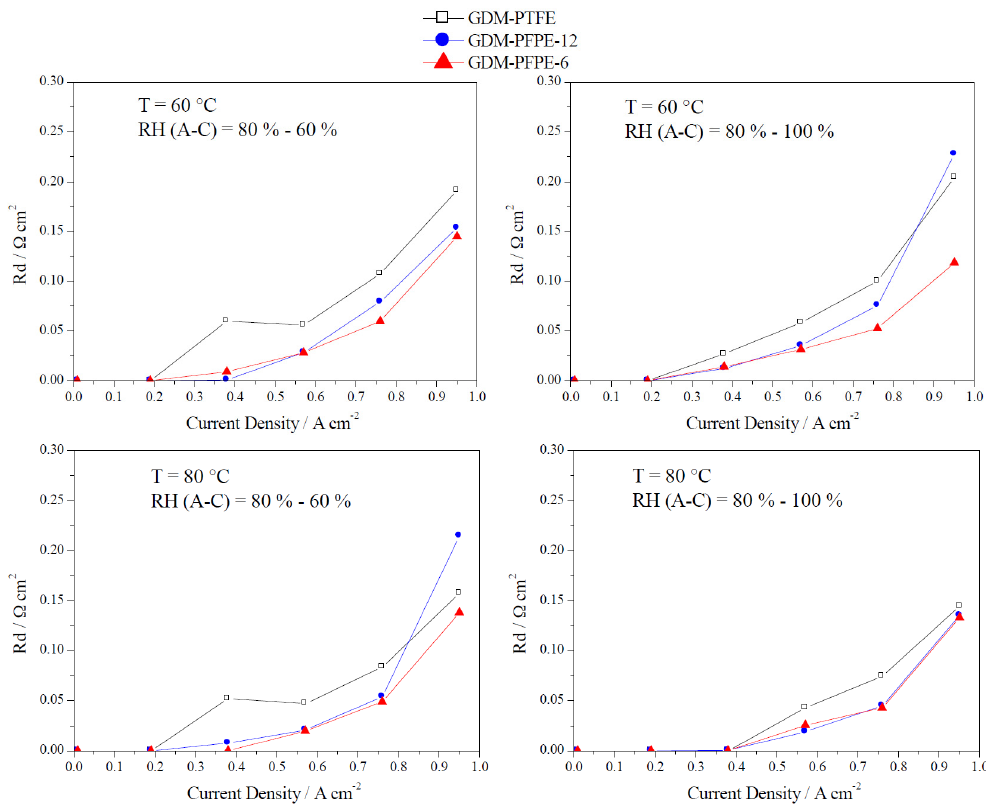
Figure 8. Diffusion resistance trend as a function of current density: fitting results comparisons at different operating